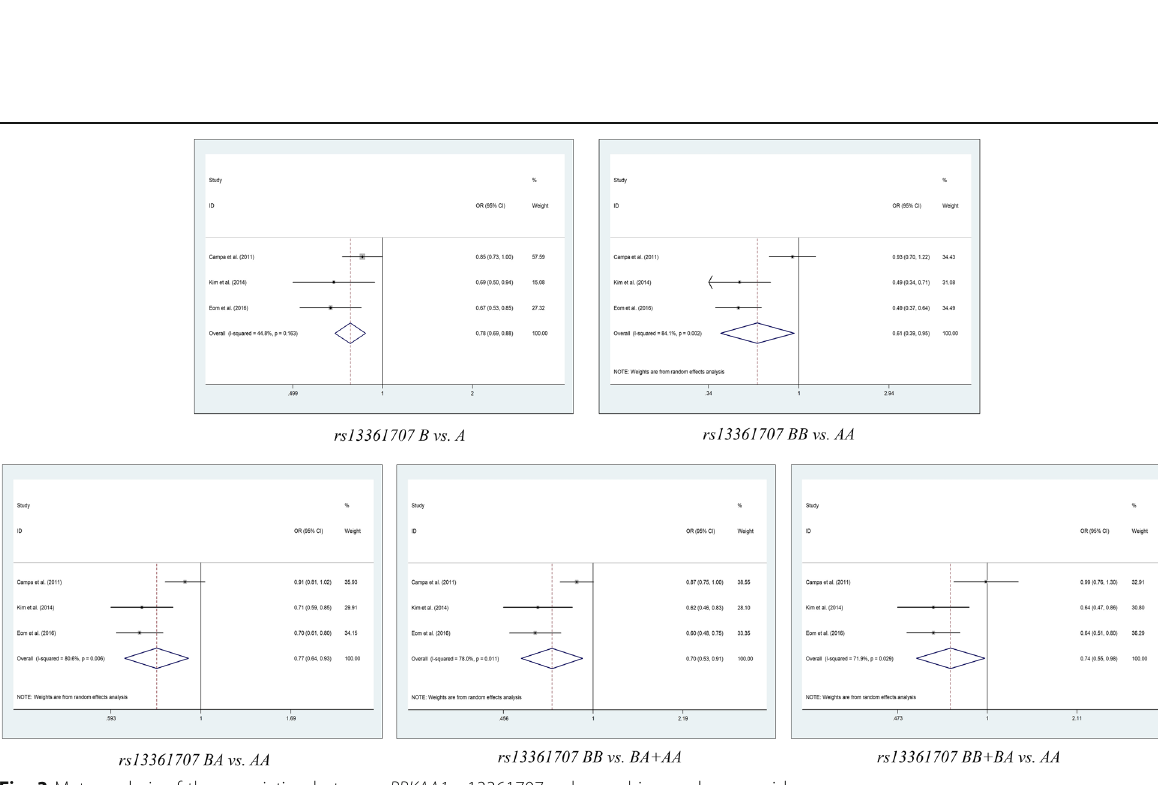
Fig. 3 Meta-analysis of the association between PRKAA1 rs13361707 polymorphism and cancer